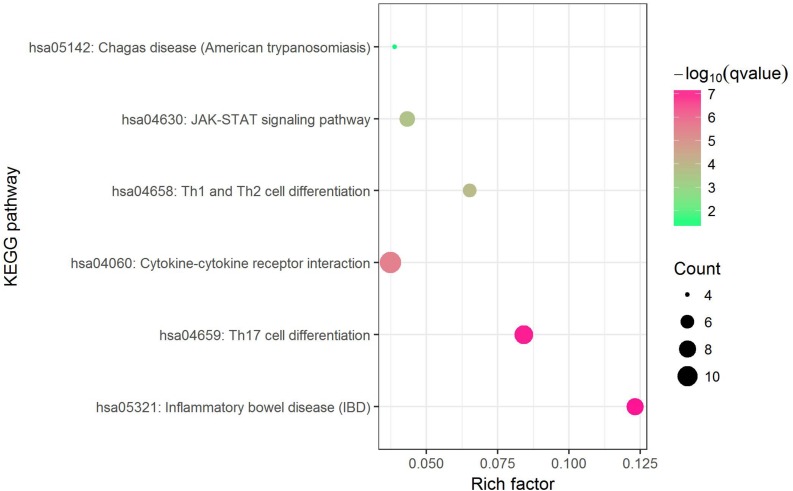
Bubble chart of enrichment analysis of shared risk genes (excluding those in MHC region).